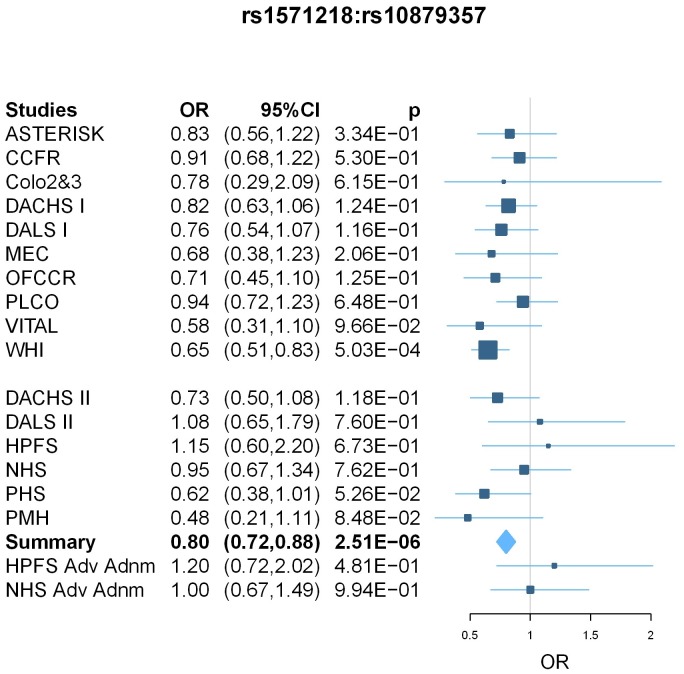
Regional interaction association plot for interacting region 5q21 with known CRC locus rs10795668.The left y-axis shows the -log10 of the meta-analysis interaction p value. The right y-axis shows the recombination rate. Each dot on the plot represents the result for one SNP. The diamond dot represents SNP rs367615 and the round dots represent other SNPs. Difference colors of SNPs indicate different LD strength between the corresponding SNP and rs367615, measured by r2. The bottom of the figure shows the genes in the plotted region.